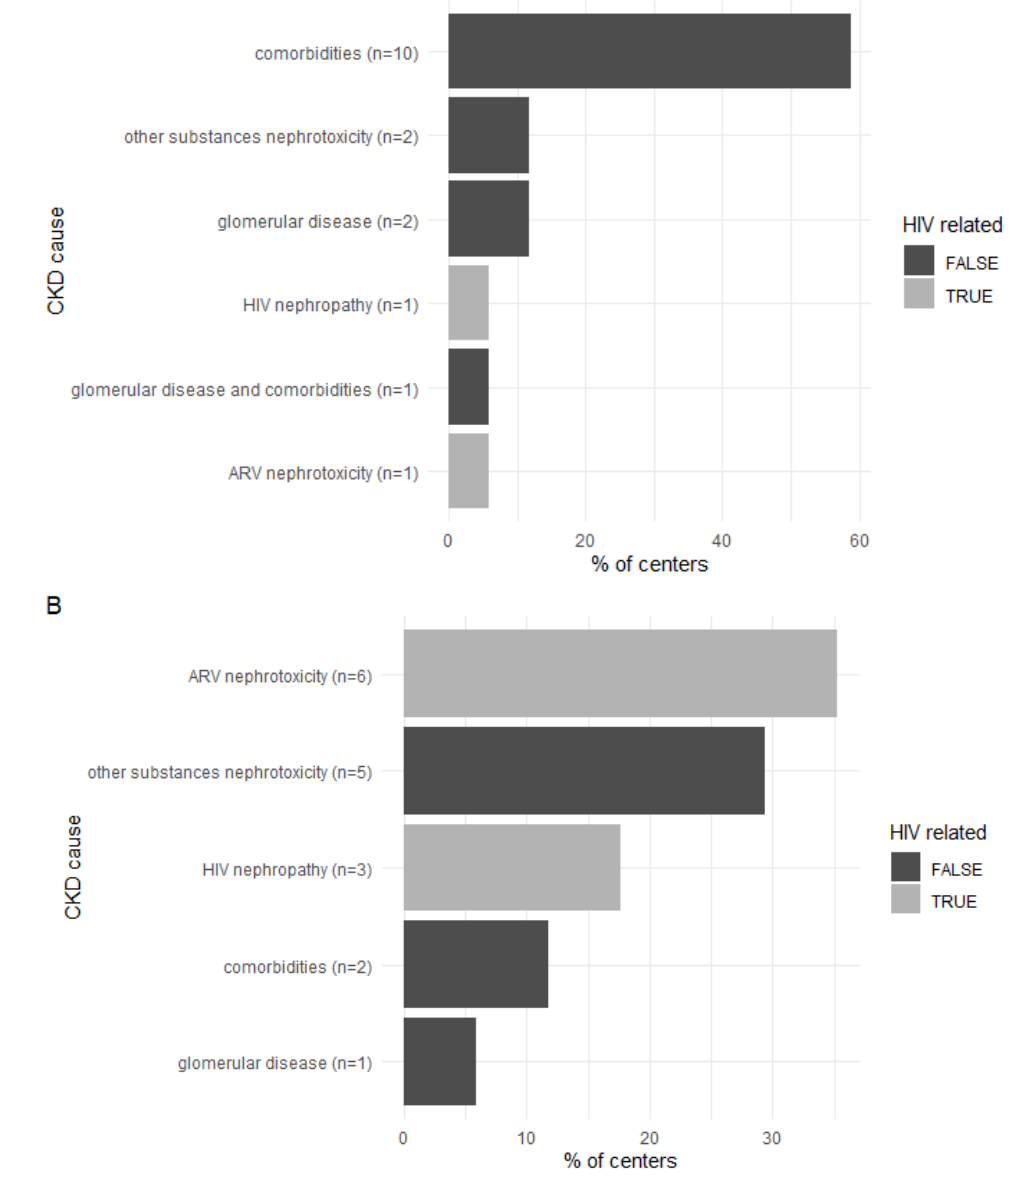
Figure 2. ( A ) The most common causes of CKD. ( B ) The second most common causes of CKD. The median frequency of CKD was 5%, although there was significant variability be- tween countries ranging from 0% to 20% of HIV-positive patients. With 37 reported cases out of over 58,000 individuals in care, end-stage renal disease is rare (0.06%) and only a few patients require RRT in most centres. Additionally, death resulting from end-stage renal disease is rare with no or single cases reported from almost all centres. The only modality of treatment for ESRD completely covered from public funding (no matter of HIV status) in all ECEE countries is haemodialysis. Respondents from four countries declared that neither living nor deceased donor transplantation is founded on public funds. In five countries, the treatment of CKD complications and peritoneal dialy- sis is not covered. Only seven centres (38.9%) declared that all treatment options for ESRD (haemodialysis, peritoneal dialysis, and kidney transplantation) are available for HIV+ patients. In 11 centres (61.1%), the only treatment option was dialysis, and among them, in 6 centres (33.3%), only haemodialysis was possible. In most centres, treatment of chronic kidney disease is the responsibility of a neph- rologist or interdisciplinary team (72.2%). In five centres (27.8%), infectious disease spe- cialists are primarily responsible for kidney care in people living with HIV. The most com- monly i ndicated barrier in kidney care was patients’ noncompliance ( six centres). Other issues (i.e., health service availability, nephrologist availability, and distance from care point) were also common. The most commonly used guidelines were EACS guidelines: eight centres (44.4%) use only EACS and seven centres (38.9%) both EACS and national ones. Guidelines adop- tion was usually described as moderate (61%) centres. 4. Discussion The reported prevalence of CKD varied from 0 to 20% (median 5%). The highest rates (more than 10%) were observed in Hungary, Poland and Serbia. A very low prevalence of CKD (below 2%) was observed in Macedonia, Georgia, Estonia and Lithuania. In the gen- eral population, the prevalence of chronic kidney disease worldwide is 1.5 – 21% and in fact, it is highly variable in seemingly similar countries such as in Europe [7,10]. Signifi- cant differences were observed even within one country [11]. Aumann et al. showed that in different regions in Germany, the prevalence may be higher by a factor of 2. In the Pomerania region (SHIP-1 study) in Northeast Germany and the region of Augsburg in Southern Germany ’s Cooperative Health Research Study (KORA F4), the prevalence was